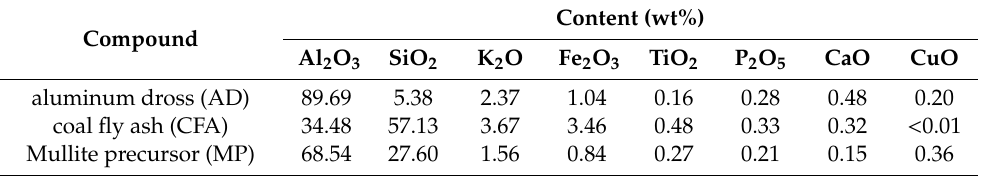
Table 1. Chemical compositions of aluminum dross (AD) and coal fly ash (CFA).